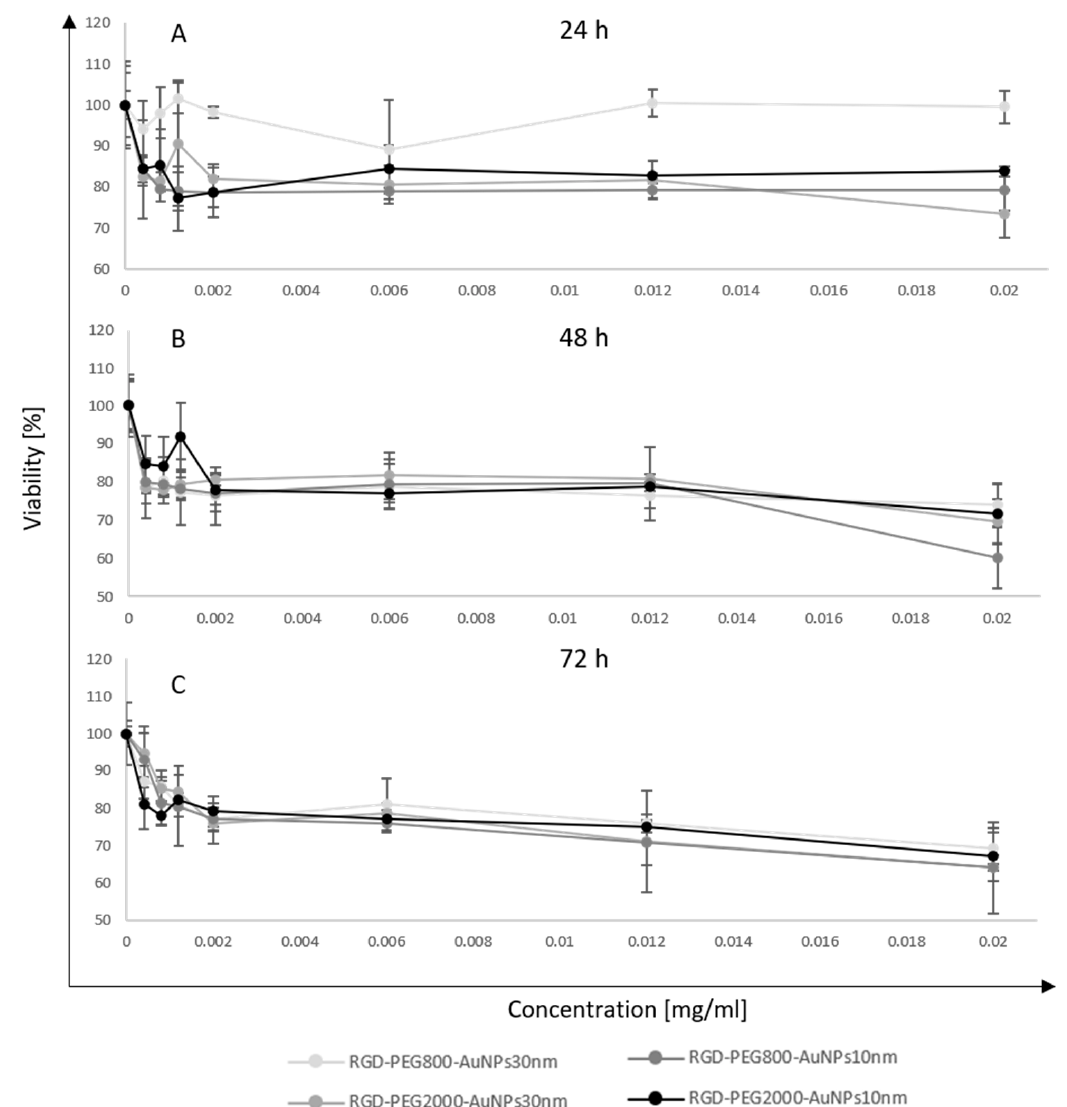
Figure 3. The viability level of the MCF-7 2D model after incubation with AuNPs. In this test, RGD-PEG 800 -AuNPs 10nm , RGD-PEG 2000 -AuNPs 10nm , RGD-PEG 800 -AuNPs 30nm , and RGD-PEG 2000 -AuNPs 30nm were used in concentrations of 0.0004, 0.0008, 0.0012, 0.0020, 0.0060, 0.0120 and 0.0200 mg/mL. The time points of incubation time with AuNPs were 24 h ( A ), 48 h ( B ), and 72 h ( C ). Table 1. The resume of the viability level of the MCF-7 2D model after incubation with AuNPs. In this test, RGD-PEG 800 -AuNPs 10nm , RGD-PEG 2000 -AuNPs 10nm , RGD-PEG 800 -AuNPs 30nm , and RGD- PEG 2000 -AuNPs 30nm were used in concentrations of 0.0004, 0.0008, 0.0012, 0.0020, 0.0060, 0.0120, and 0.0200 mg/mL. Abbreviations: SD—standard deviation.